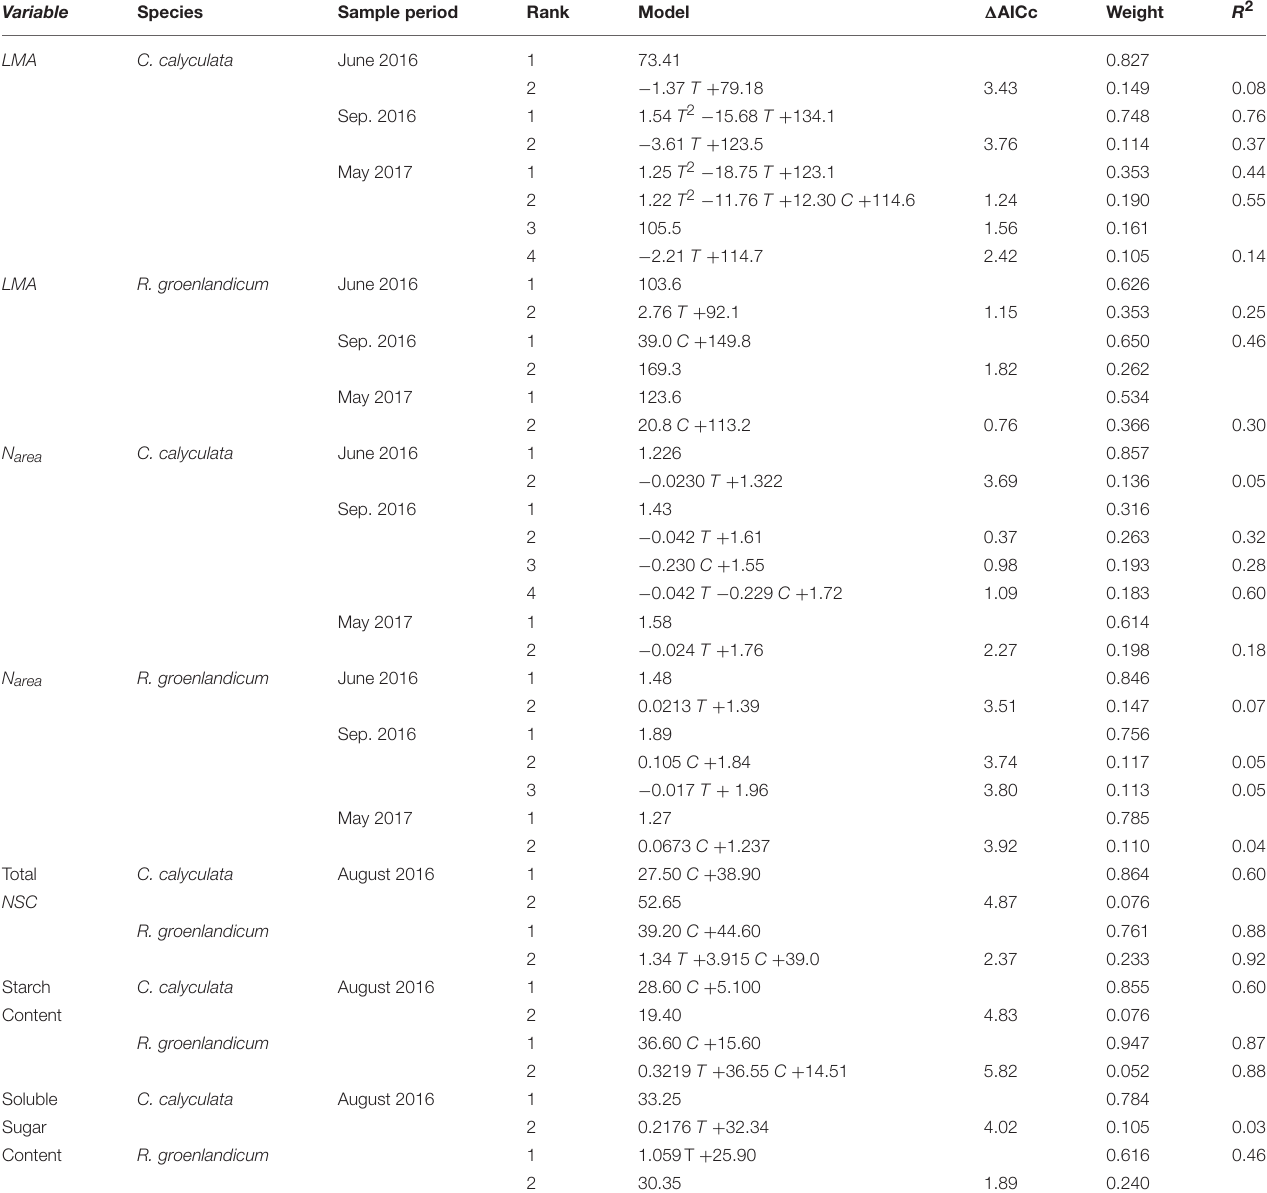
TABLE 2 | Top two models for each leaf structure and chemistry variable, species, and measurement period as evaluated by Akaike Information Criterion corrected for sample size (AICc) for the independent variables temperature ( T , Celsius) and elevated [CO 2 ] treatment ( C , 0 = ambient [CO 2 ], 1 = + 500 ppm). Variable Species Sample